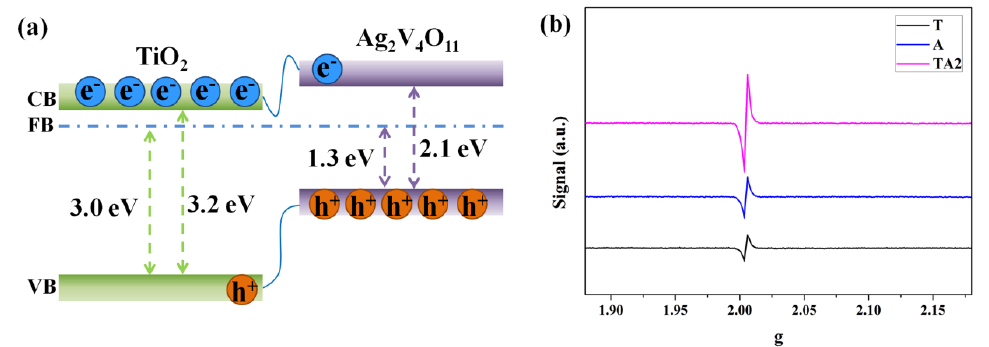
Figure 8. ( a ) Schematic illustration of energy band matching and the proposed mechanism of free electron–hole pairs’ transfer route for TA nanoheterojunctions under visible light irradiation, ( b ) EPR